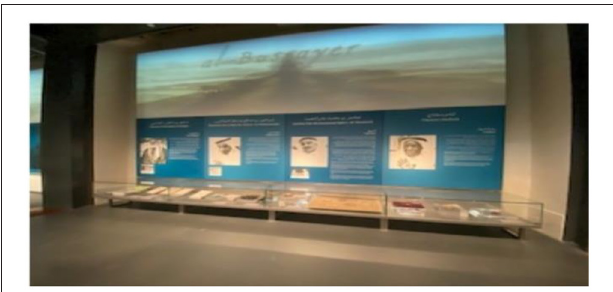
FIGURE 6 | The bare hands or “ alsawaeid alsumer ” exhibit.